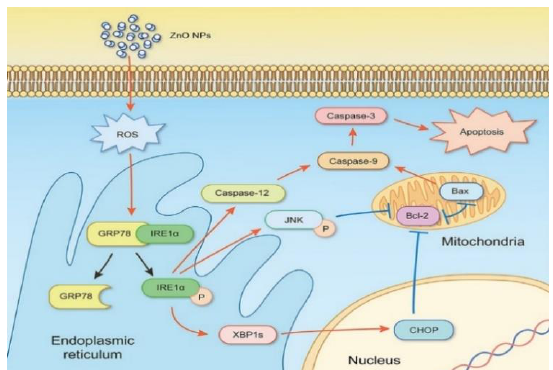
Figure 42. Schematic illustration for activating ER-stress pathway in the testis of male mice treated with ZnO NPs. Simultaneous mitochondrial apoptosis leads to Bax/Bcl2 signaling, caspase 9 and